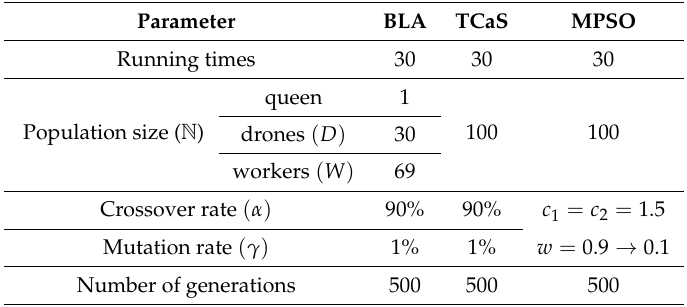
Table 6. BLA, TCaS and MPSO